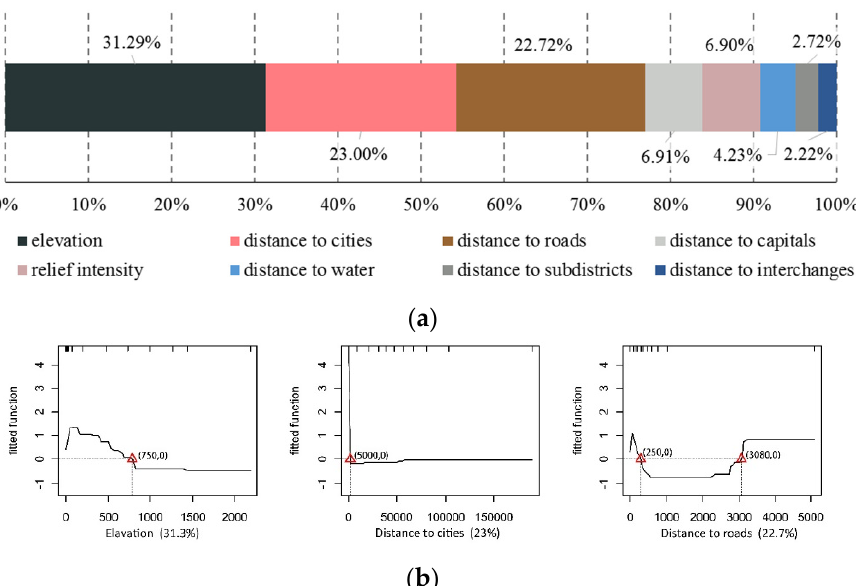
Figure 11. Factor contribution ranking and marginal effect of ES–LS. ( a ) Contribution degree of factors; ( b ) marginal effect of factor with a contribution degree over 10%.